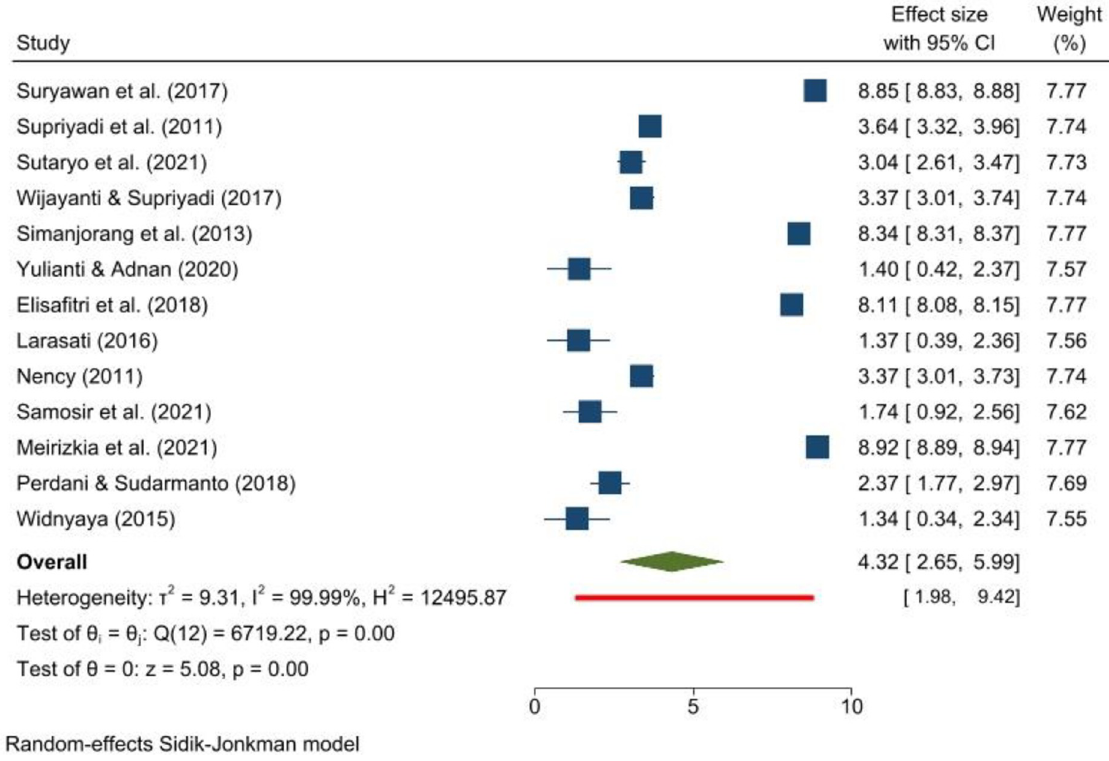
Fig 1. Forest plot showing the incidence rate and prediction interval of childhood acute lymphoblastic leukemia (per 100,000 children).